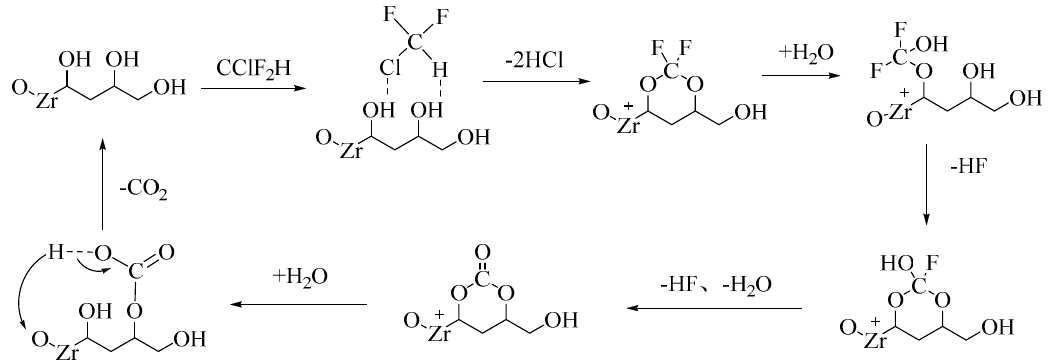
Figure 13. Schematic drawing of the catalytic hydrolysis of HCFC-22 by MoO 3 /ZrO 2 . Zirconium hydroxide exists in the form of tetramer [Zr 4 (OH) 8 (H 2 O) 18 ] 8+ , which is dissolved in water and converted into tetramer ion [Zr 4 (OH) 14 (H 2 O) 10 ] 2+ . Each zirconium atom contains 2–3 non-bridging hydroxyl groups. Zirconium tetramers are bonded by hydroxyl bridge bonds to form a polymer [Zr(O x (OH) 4 − 2x • yH 2 O]. The CO 2 -TPD and XRD